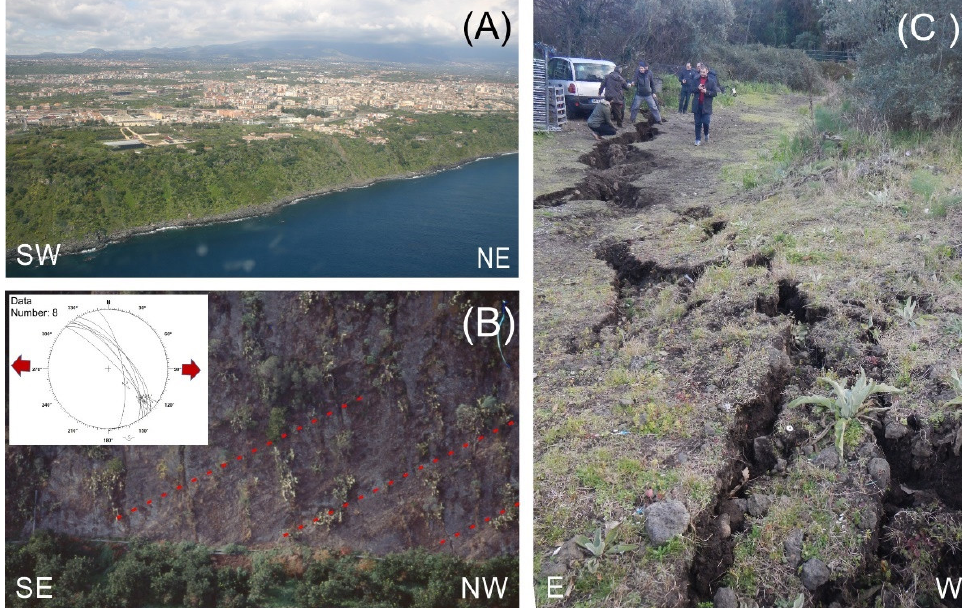
Figure 3. ( A ) View from the south-east of the Acireale Fault scarp. ( B ) View from the north-east of kinematic indicators of oblique motion (dextral-normal) along the south-eastern sector of the Linera–S.Tecla fault scarp; inset shows the stereographic projection (Daisy3 software) of fault planes and slickenlines measured in this site; the red arrows indicate the computed extension direction. ( C ) View from the north of the N–S-trending left-stepping en-echelon open ground fractures formed during the 26 December 2018 seismic event along the Fiandaca fault. See Figure 2 for locations.